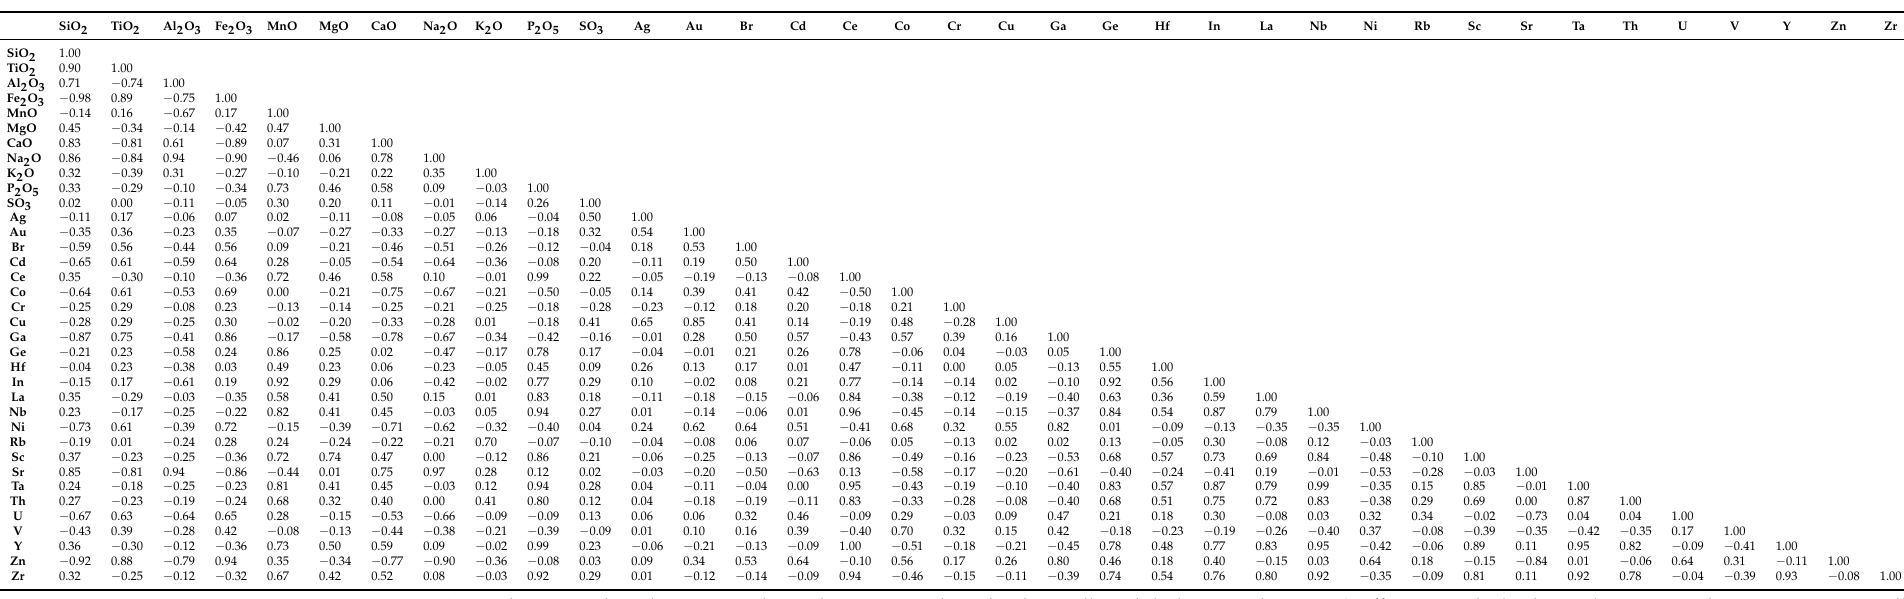
Table 8. Pearson’s correlation coefficients of selected elements for the bulk-rock samples from Fe-Ti-V deposits in